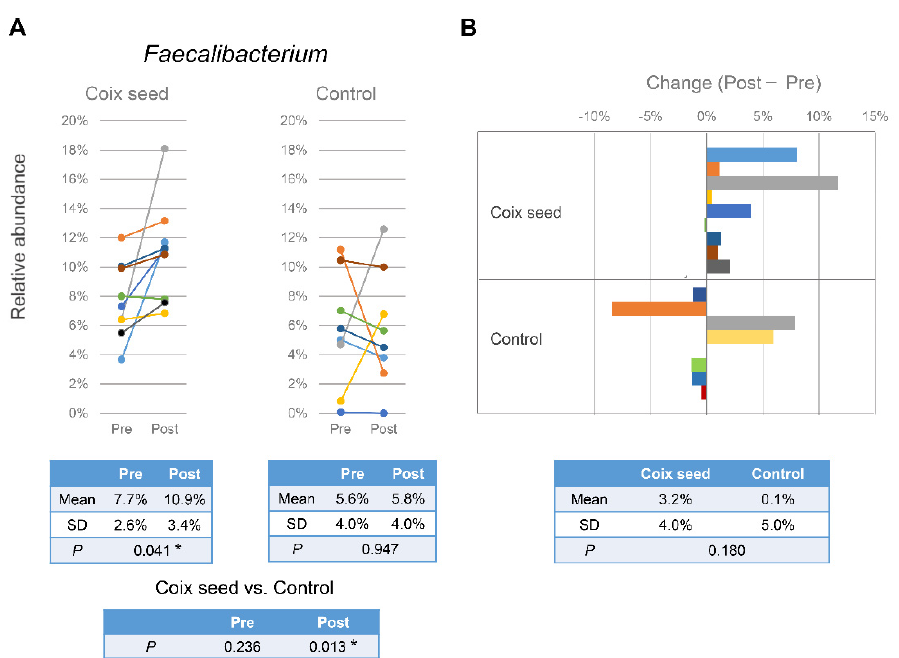
Figure 4. Intestinal Faecalibacterium relative abundance as identified in each participant before and after the intervention ( A ), and the recorded change between the post- and the pre-intervention (Post -Pre) samples in each participant as a percentage ( B ).